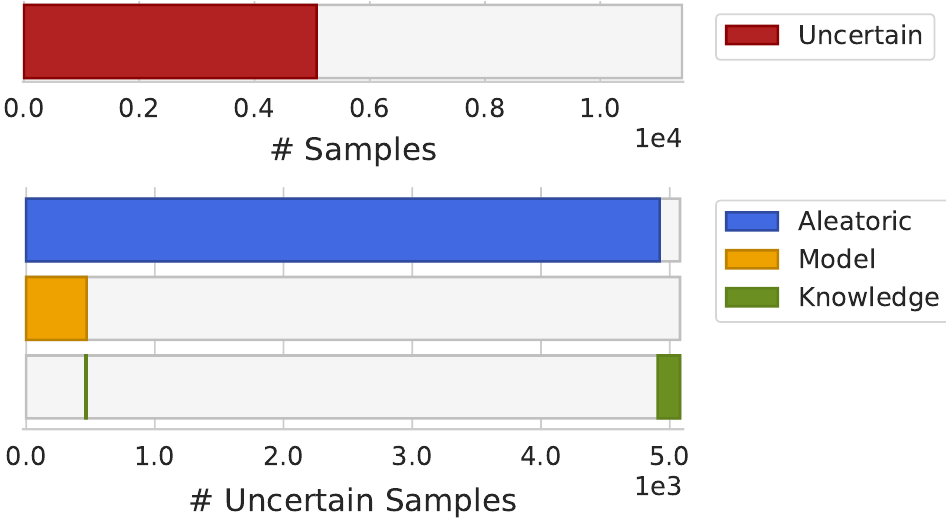
Figure 6. Overview of the overall dataset uncertainty ( upper bar ) and uncertainties distribution by the uncertainty source ( lower bars ).